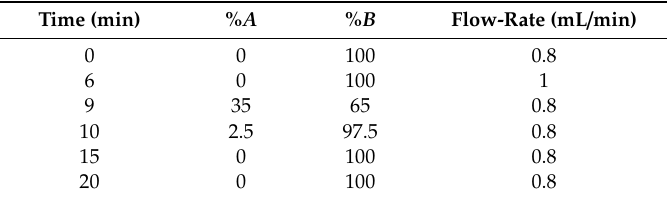
Table 2. HPLC multistep binary elution gradient used for the separation of organic acids by